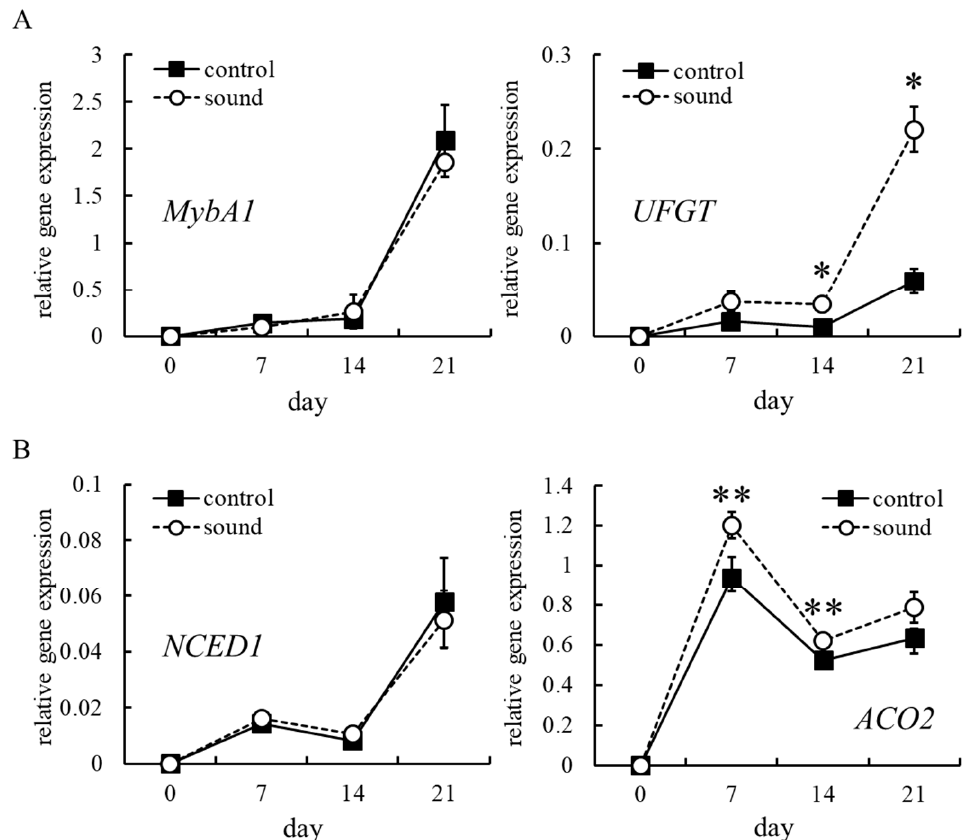
Figure 3. Transcription of MybA1 , UFGT , NCED1 , and ACO2 in VR cells exposed to sound stimulation. ( A ) MybA1 and UFGT . ( B ) NCED1 and ACO2 . VR cells were exposed to sound stimulation 7, 14, and 21 d after treatment. The transcription level of each gene was estimated by real-time RT-PCR. Data were calculated as gene expression relative to actin expression. Data indicate means ± standard errors of two independent experiments with three VR cell masses. * p < 0.01, ** p < 0.05 compared with control (Student t -test). Control: no treatment. Sound: sound stimulation at 1000 Hz.